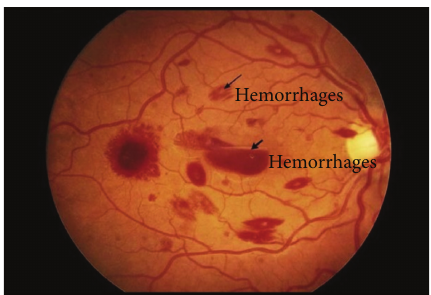
Figure 7: Hemorrhages in fundus image.